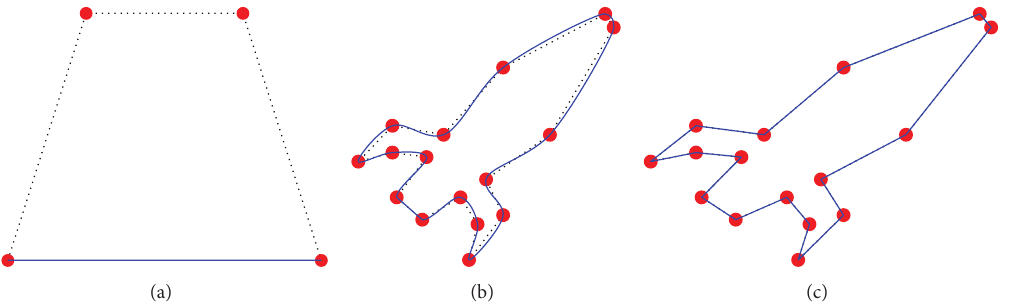
Figure 5: Rational cubic spline interpolant: (a) linear interpolant, that is, 𝛼 𝑖 ,𝛿 𝑖 → 0 , and (b) interval tension property, that is, 𝛼 𝑘 , 𝛿 𝑘 → 0 , 𝑘 = 10 . (c) Global tension property, that is, 𝛼